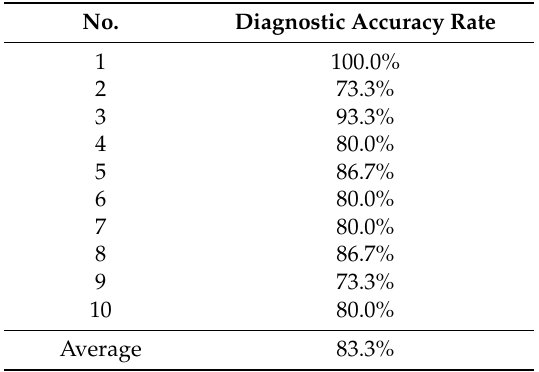
Table 7. Identification accuracy rate of 10 groups’ randomly chosen testing sets